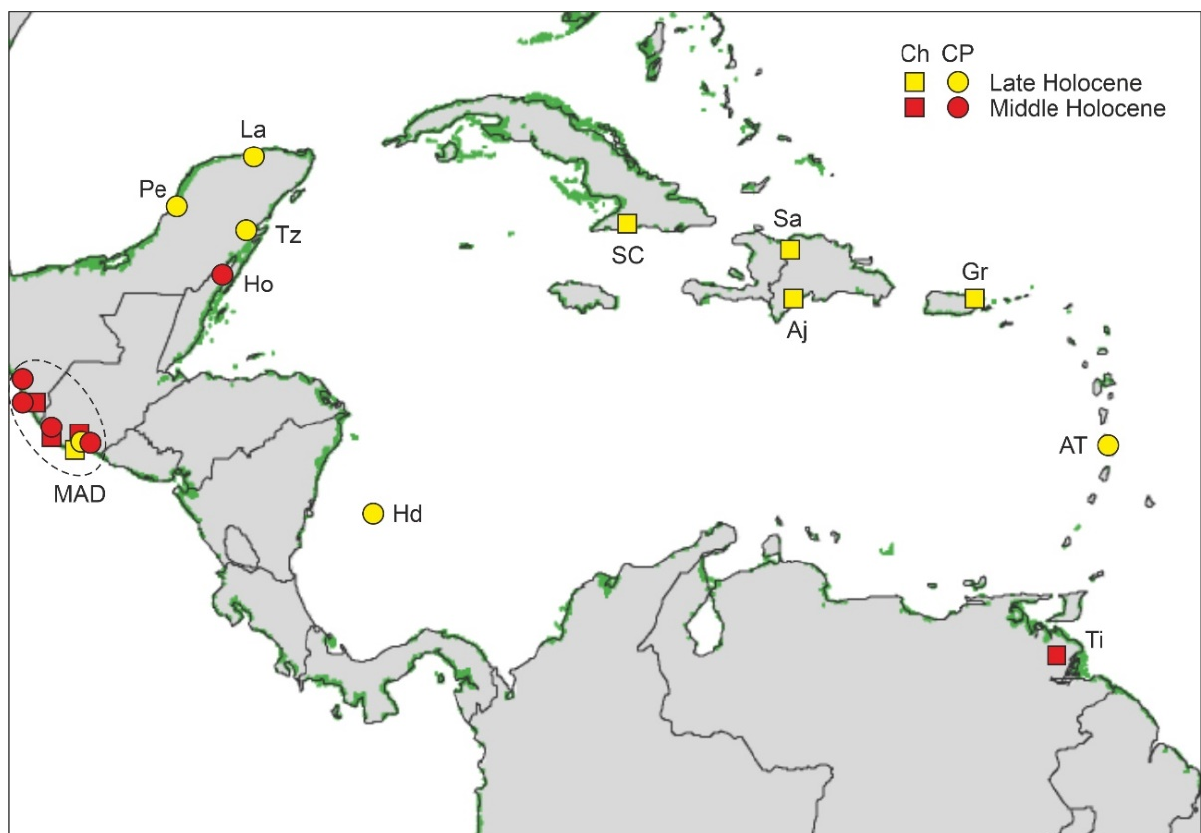
Figure 18. First appearances of pollen from cultivated plants ( Zea mays and Cucurbitaceae) and charcoal amounts/patterns compatible with anthropogenic fires in Caribbean mangrove records. Raw data from Table 3 (see also Figure 15). Ch, charcoal; CP, cultivated plants; MAD, Mesoamerican Archaic Disturbance event.